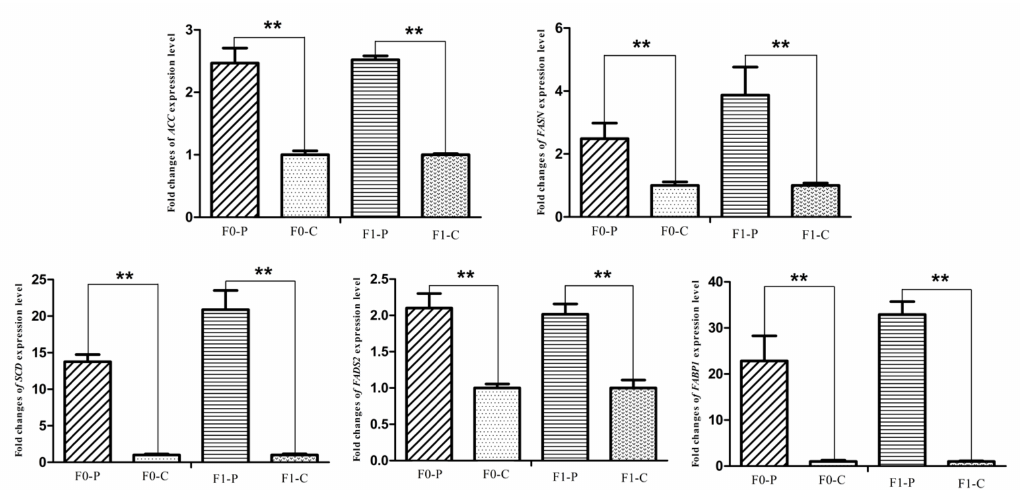
Figure 9. Fold changes of fatty acid metabolism genes ( ACC , FASN , SCD , FADS2 ) and lipid metabolism gene ( FABP1 ) expression levels between P (paternal inheritance group) and C (control group) in F0 and F1 generations. ** indicates p < 0.01.